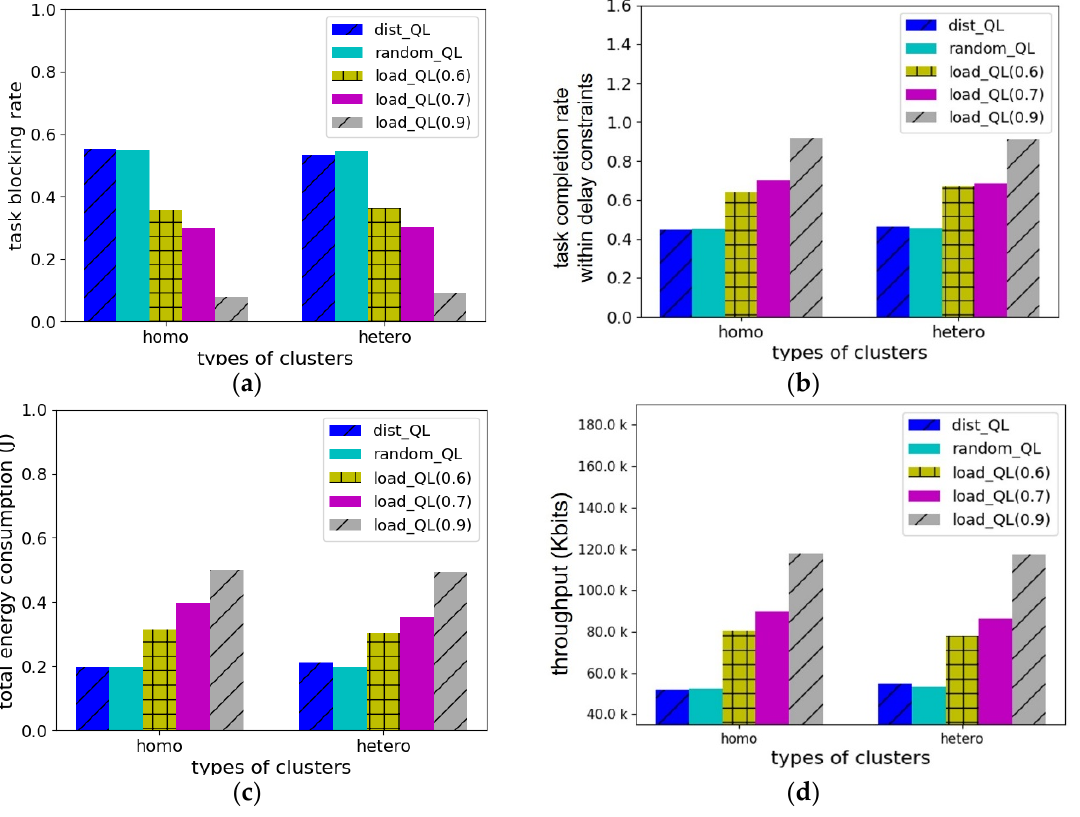
Figure 4. Performance comparison according to cluster types when using different target MECS and D2D device selection methods with the same optimal offloading strategy (the number of devices is 52 and task arrival rate is 0.8): ( a ) task blocking rate; ( b ) task completion rate within delay constraints; ( c ) total energy consumption( J ); ( d ) throughput.